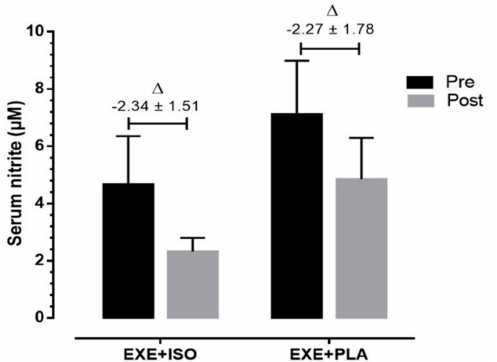
Figure 3. Values of serum NO 2 − variation in both placebo (PLA) and isoflavone (ISO) groups. EXE: exercise; ∆ : final minus baseline values. ANOVA two way was used to compare groups and time. Student t -test was used to compare delta